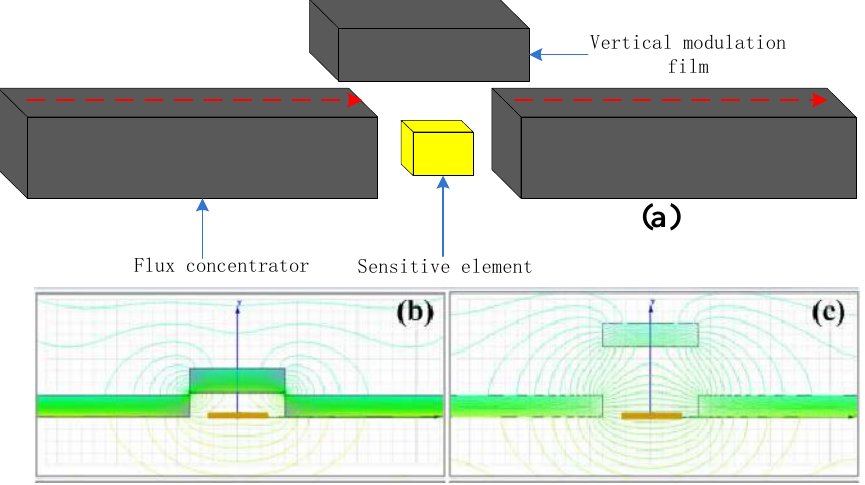
Figure 5. ( a ) The flux modulation micro-structure ( b ) TMR sensor with flux concentrators and choppers at OFF position ( c ) The choppers at ON position, the green line represents the size and direction of the magnetic field in the simulation.